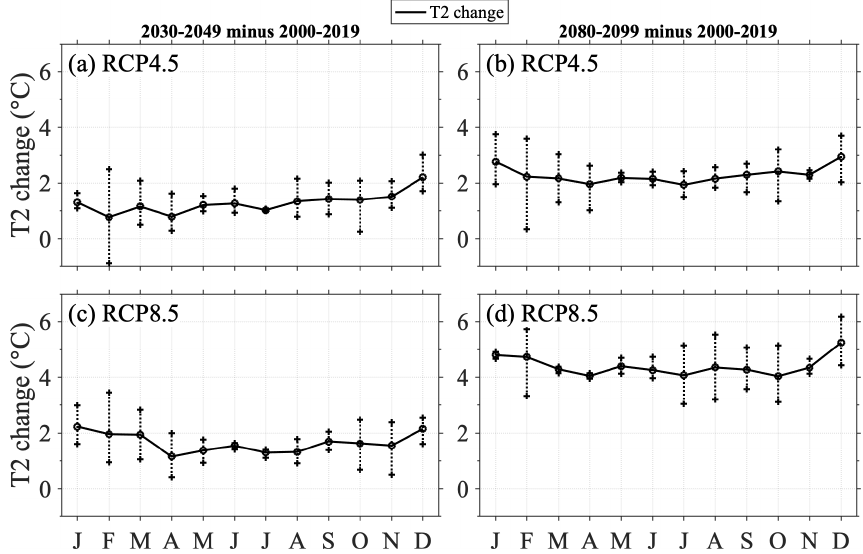
Figure 7. Projected changes in monthly surface air temperature over the Great Lakes basin in the mid-century (2030–2049) and late century (2080–2099) for the RCP 4.5 (a, b) and RCP 8.5 (c, d) scenarios, relative to the present-day climate (2000–2019). Vertical error bars indicate the range of the three individual GLARM